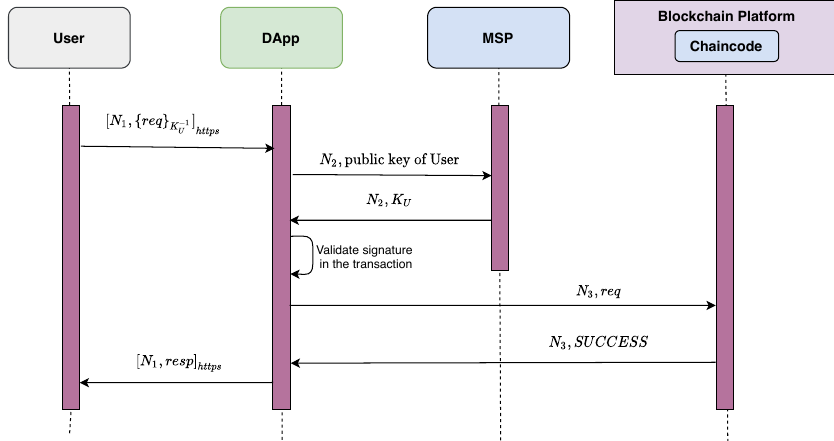
Figure 4. Car creation and query flow.